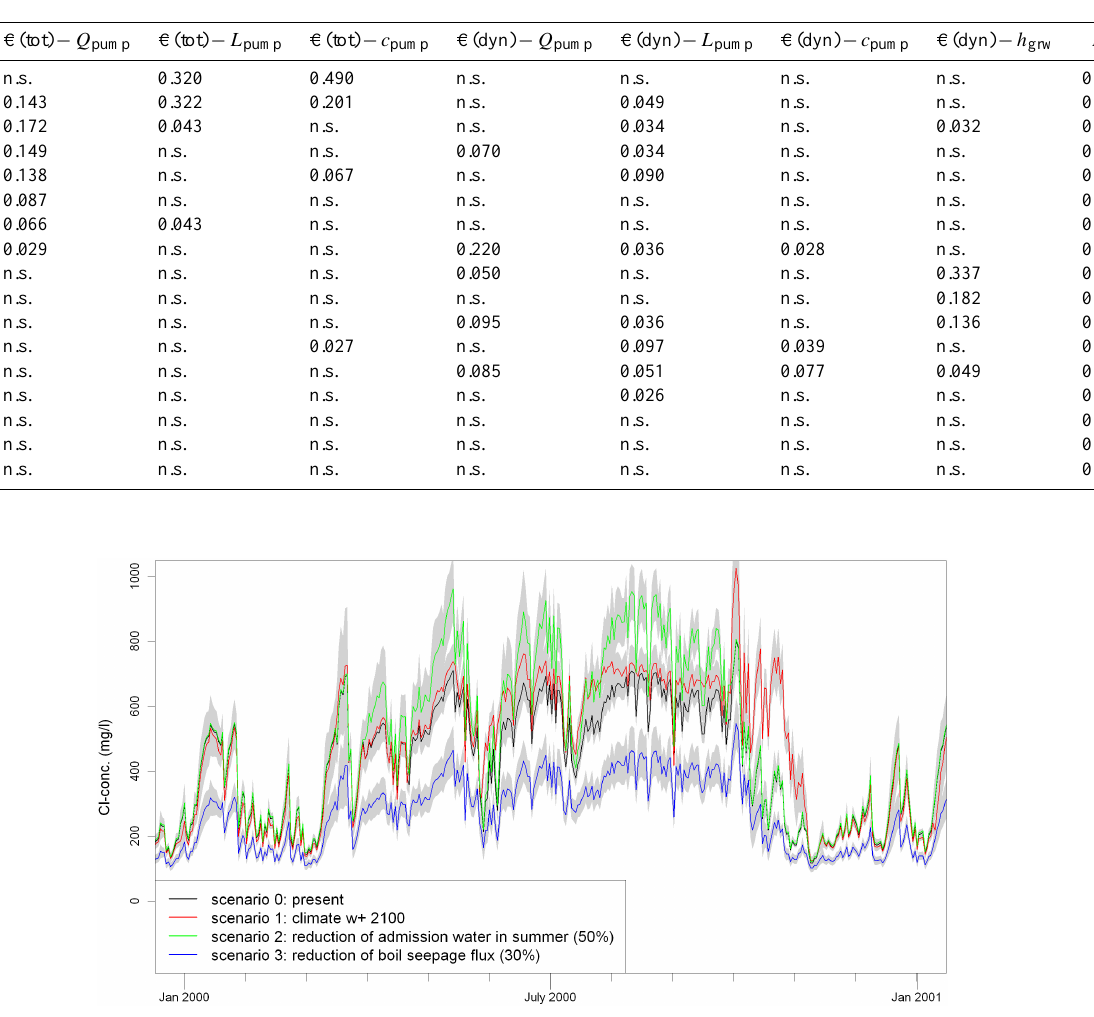
Fig. 7. Calculated chloride concentration of the polder water discharge for different scenarios. The coloured lines give the mean value and the grey areas present the uncertainty range (mean ± standard deviation) derived from 59630 simulations with behavioural parameter sets of GLUE analysis